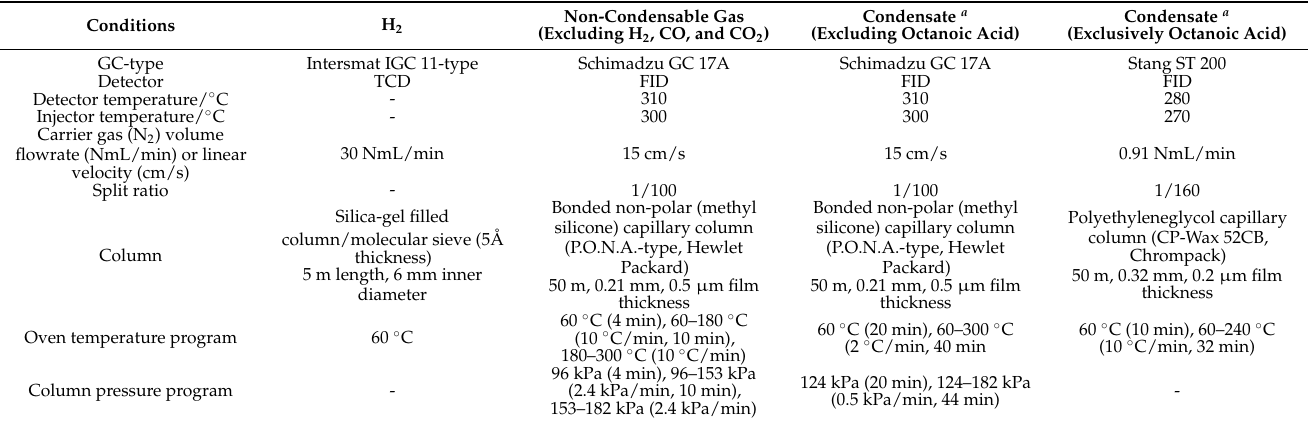
Table A1. Conditions of gas chromatography analyses